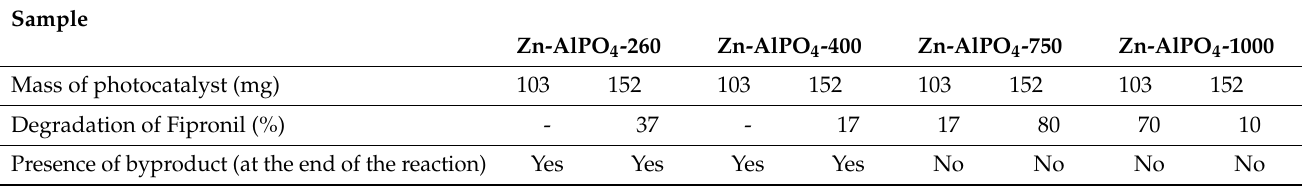
Table 3. Evaluation of the photodegradation of fipronil as a function of the mass and calcination temperature of Zn-AlPO 4